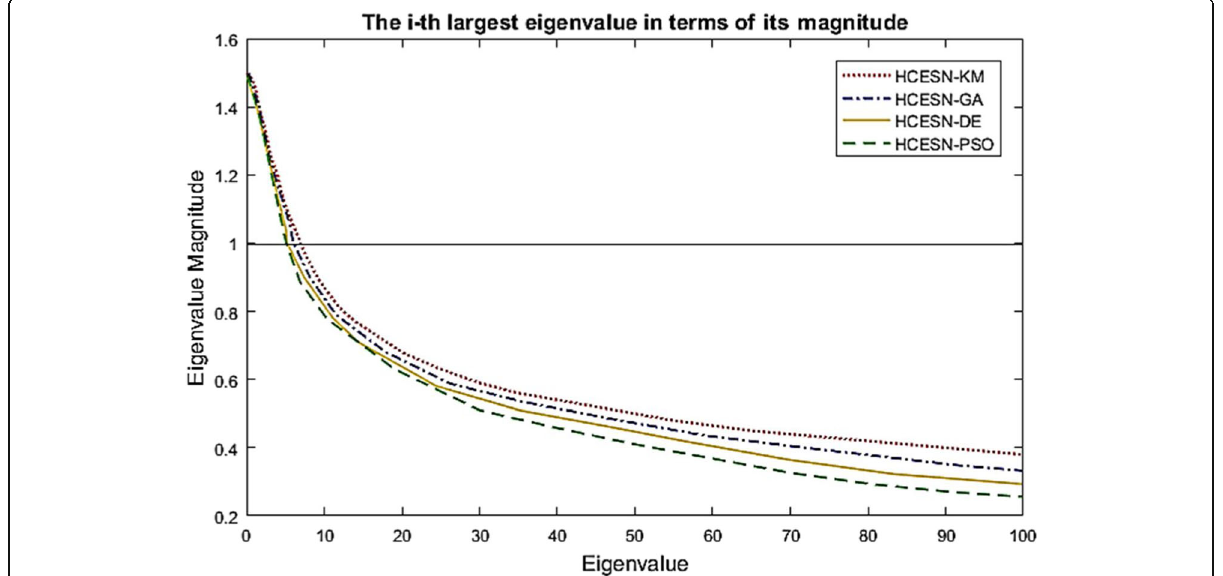
Fig. 9 HCESNs in a wide range of 100 eigenvalues with a spectral radius of